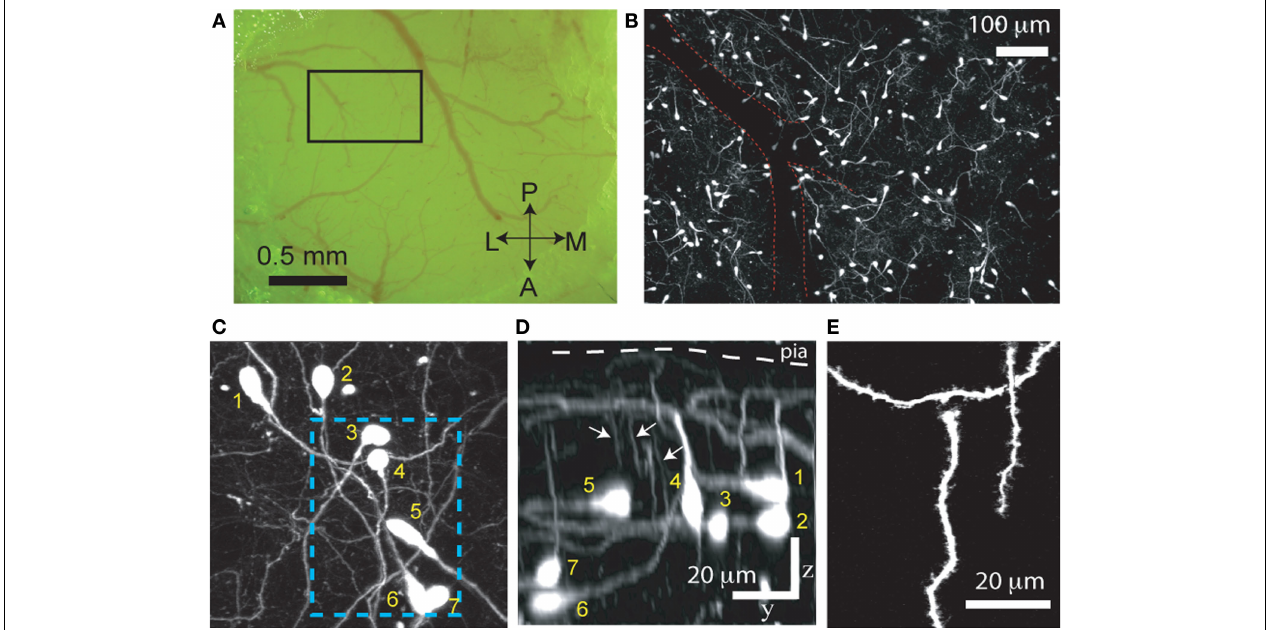
FIGURE 1 | GFP + cells in Ebf2 mice display the typical morphological features of Cajal–Retzius neurons. (A) Photomicrograph of the cranial window taken through the ocular of the two-photon microscope. A two-photon image of the boxed region is shown in panel (B) . A, anterior; P, posterior; M, medial; L, lateral. (B) Low magnifi cation two-photon image of GFP + cells in somatosensory cortex of a P8 Ebf2-GFP mouse. The image is a composite maximum intensity projection (MIP) of six stacks, each consisting of 30–35 slices, 3 µm apart. An overlying dural vessel (red outline) partially obscures some of the fl uorescence. (C) Higher magnifi cation two-photon image (MIP of 57 slices, 2 µm apart) demonstrating that GFP-expressing cells have an oval cell body and a single (or sometimes two) main